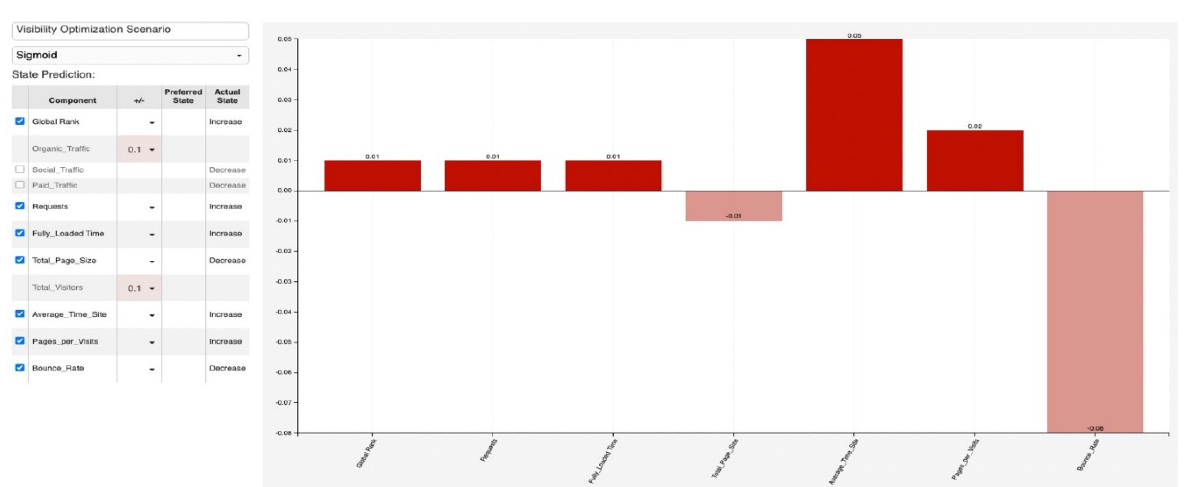
Figure 3. Visibility Factor Optimization Scenario.